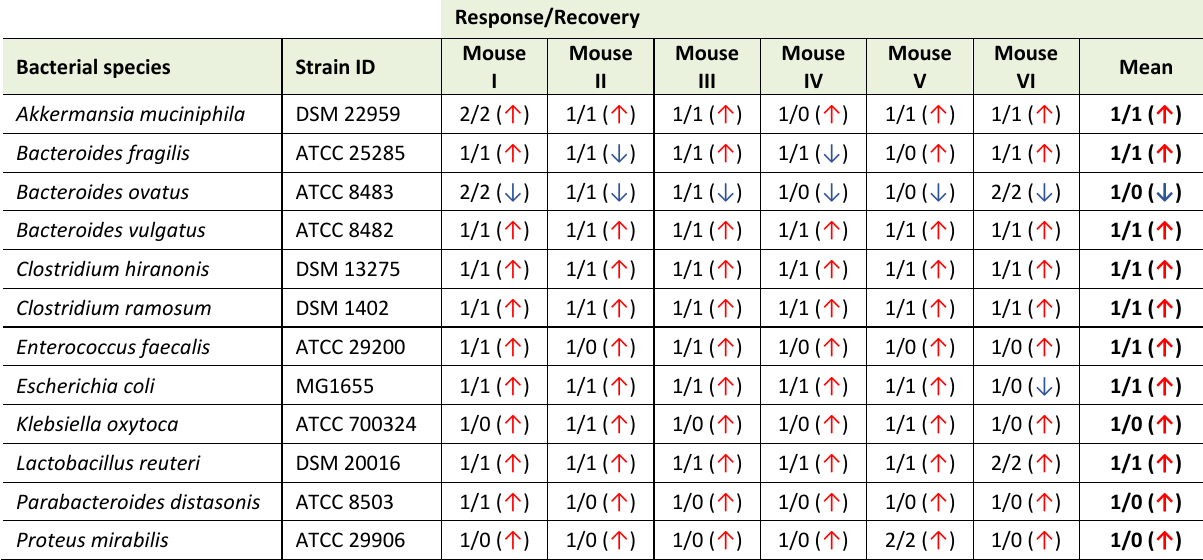
TABLE 1. Results of changepoint analysis describing the dynamics for every bacterium in each mouse . 'Response' indicates a change from the pre-treatment level, while a 'recovery' marks a subsequent change in the opposite direction. Arrow indicates the direction of the response relative to the pre-treatment